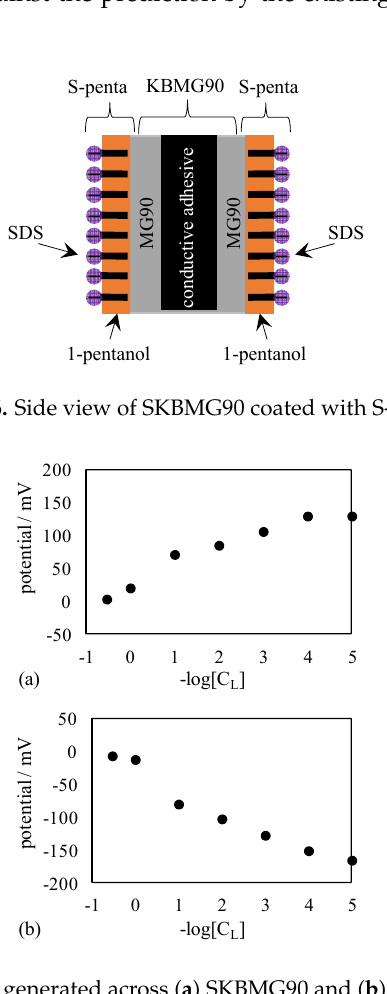
Figure 7. Membrane potential generated across ( a ) SKBMG90 and ( b ) CKBMG90 against –log[C L ]